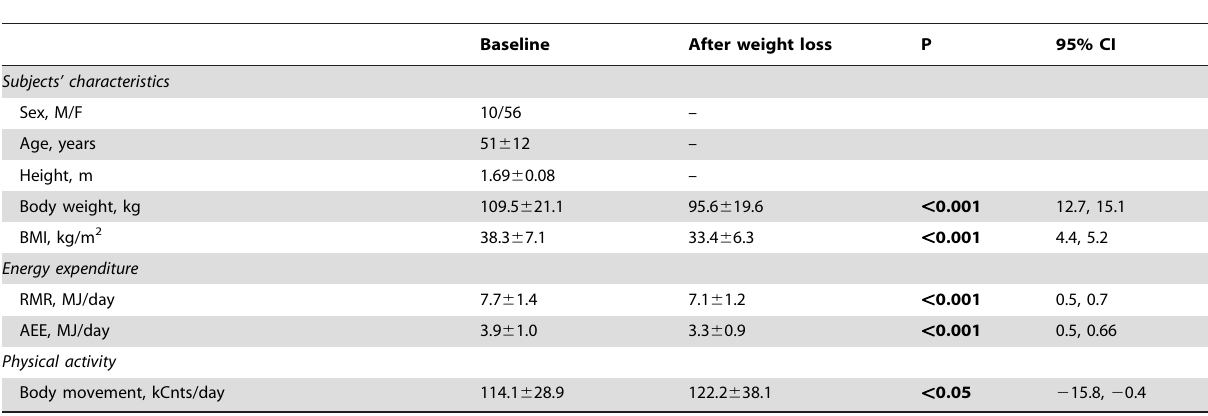
Table 1. Subjects’ characteristics (n=66), energy expenditure and physical activity at baseline and after weight loss.